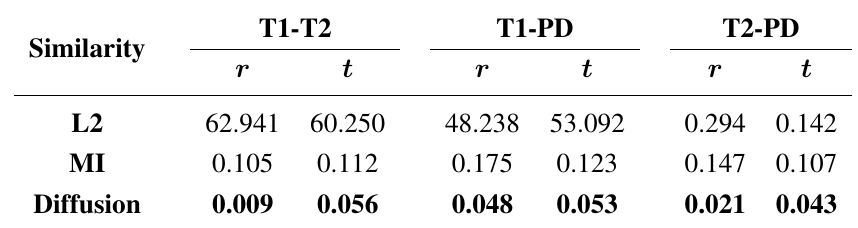
Table 1. Mean (rigid) registration error for BrainWeb data sets. Rotation errors r are in degrees, and translation errors t are in mm. PD, proton density; MI, mutual information.